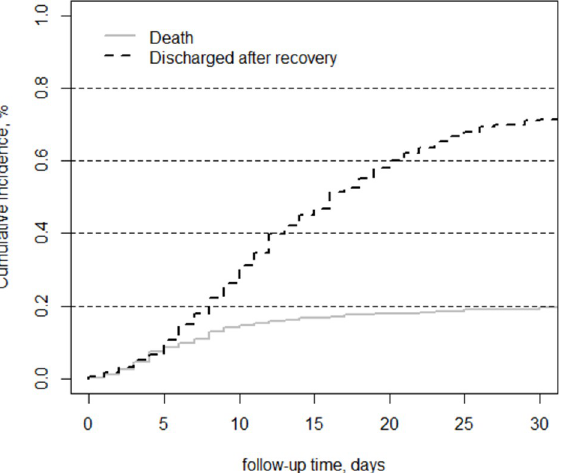
Fig 1. Cumulative incidence function of 501 COVID-19 patients hospitalized in the region of Lombardy, Italy, during the first COVID-19 wave (Feb-May 2020).